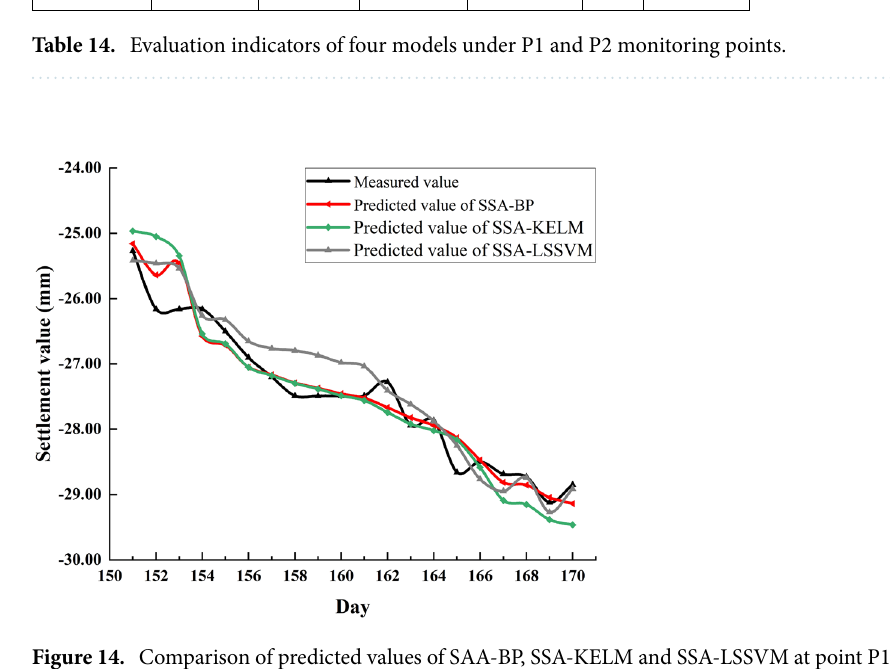
Figure 14. Comparison of predicted values of SAA-BP, SSA-KELM and SSA-LSSVM at point